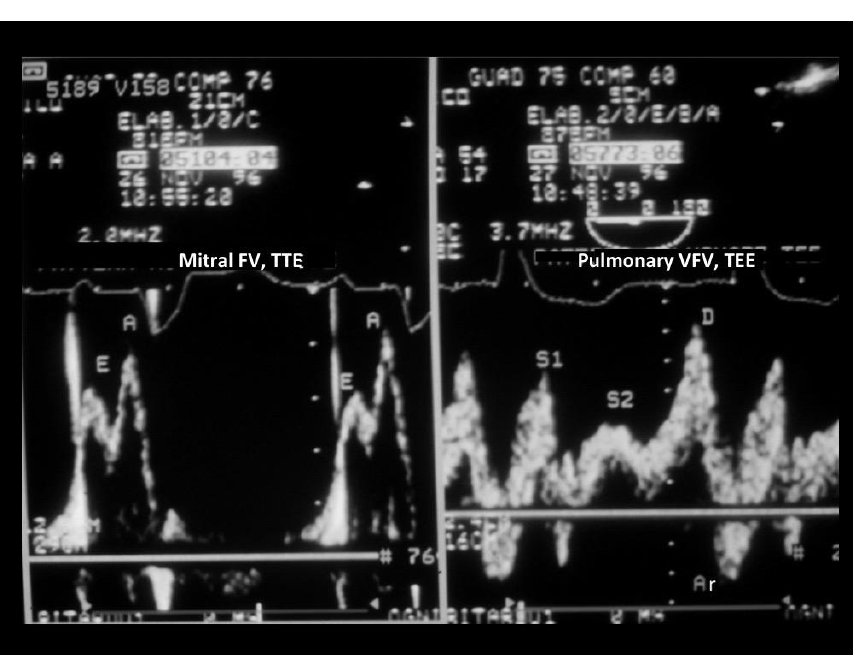
Figure 4. TEE recording of the mitral and pulmonary venous flow velocity in a patient with DCM and a reduced peak VO 2 (12 mL/kg/min). On the left, mitral flow velocity is displayed (in this case, mitral flow was attained with a transthoracic approach); the E/A ratio of the mitral waves was 0.7, the same E/A ratio as in the patient in Figure 3. On the right, pulmonary venous flow is shown: the systolic fraction of the venous flow, differently from the case illustrated in Figure 3, was reduced (<50%), indicating this time a restriction of LV filling that predicts an increase in the Pre-a filling pressure. Arv-A was not computed as it is difficult to pinpoint the beginning of the mitral A-wave (precociously fused with the E-wave). There was a broadening of the pulmonary Doppler signal, so modal velocity was traced. TEE = transesophageal Doppler echocardiography; FV = flow velocity; VFV = venous flow velocity. Using ≤59% of S Fract as a cutoff, identified using ROC curve analysis (area under the curve = 0.69, 95% CI: 0.87 – 0.98; p < 0.0001), the sensitivity and specificity of predicting a reduced peak VO 2 consumption were 61% and 72%, respectively (Figure 5).